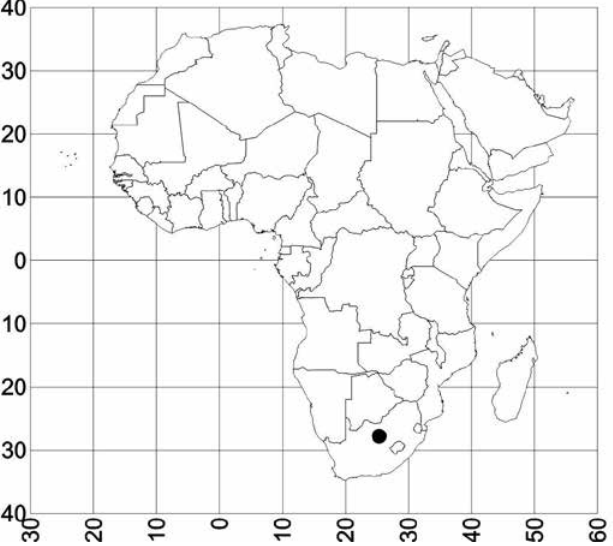
Map 5 . The distribution of B. cavernosa